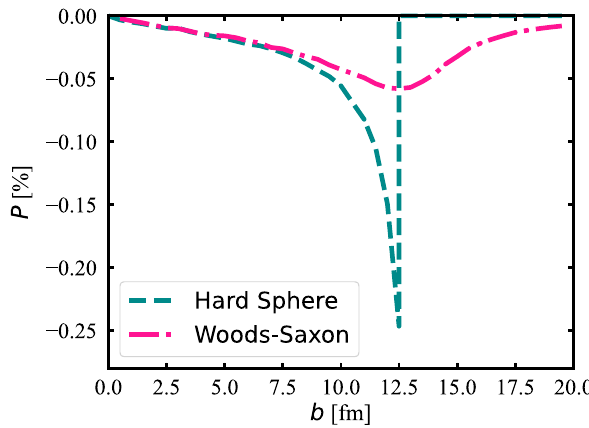
Fig. 5 Theinitialglobalpolarizationasafunctionoftheimpactparam- eter,comparedbetweenHardSphereandWoods–Saxonnucleardensity distributions imized around the boundary of the overlapping region, its magnitude decreases smoothly outside the boundary instead of suddenly vanishes because of the different location ( x , y ) dependences of the nuclear density between Eqs. (6) and